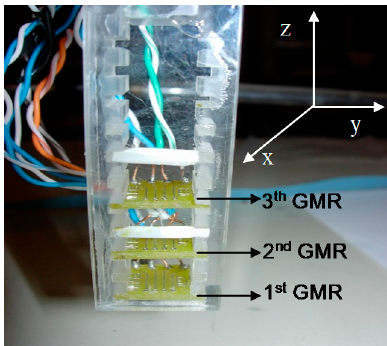
Figure 5. GMR 2nd order electronic gradiometer. It detects the in plane (y-axis) magnetic field component reducing the environmental interference.